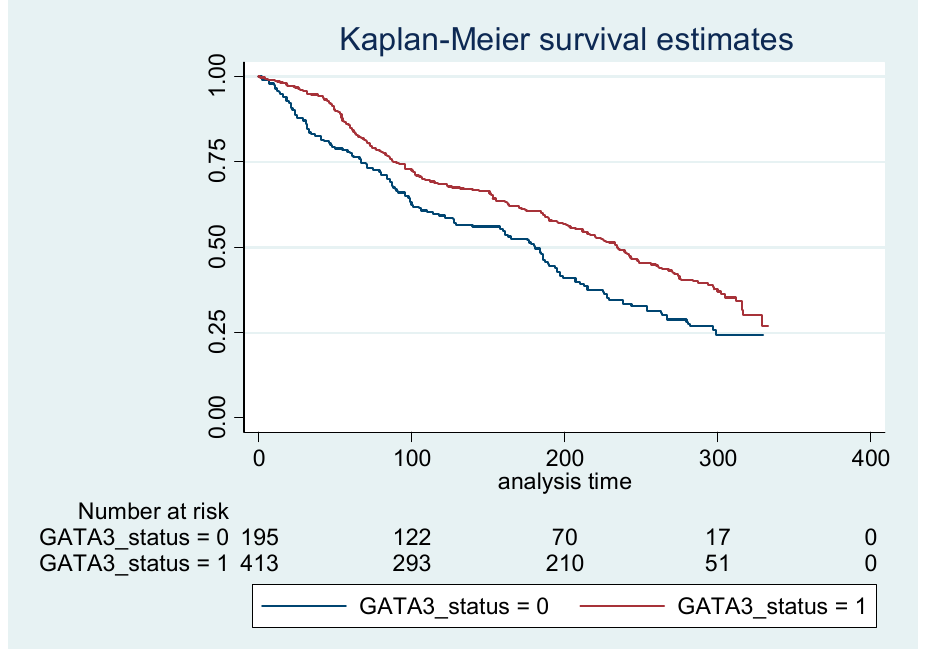
Figure 4. Kaplan–Meier survival curve analysis of GATA3 in breast carcinomas. The age-adjusted hazard ratio for death was 0.70 (95% confidence interval 0.56–0.86).